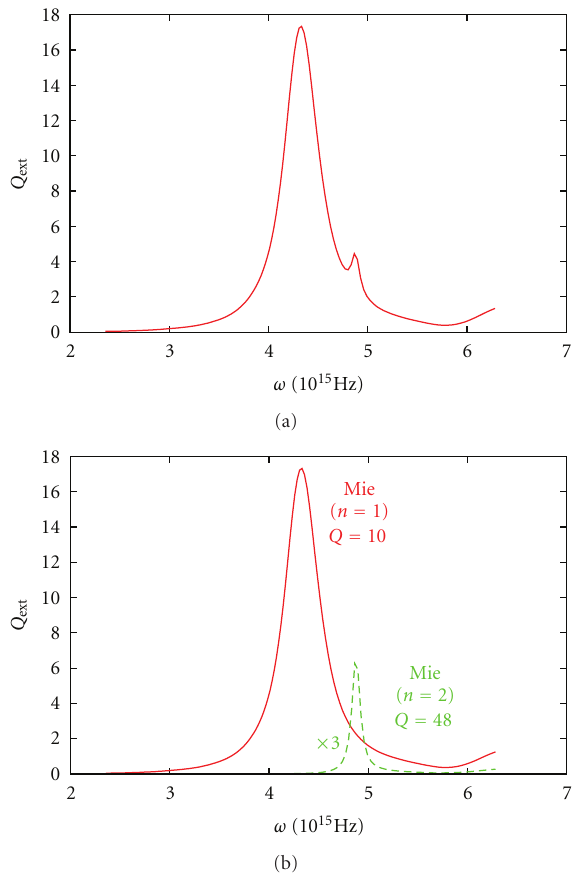
Figure 3: (a) Extinction e ffi ciency of a R = 25nm silver sphere embedded in PMMA, calculated using full Mie expansion. (b) Contribution of the dipolar ( n = 1) and quadrupolar ( n = 2) mode to the full extinction e ffi ciency. The quality factor is indicated for each mode. Dielectric constant for silver is taken from [28].